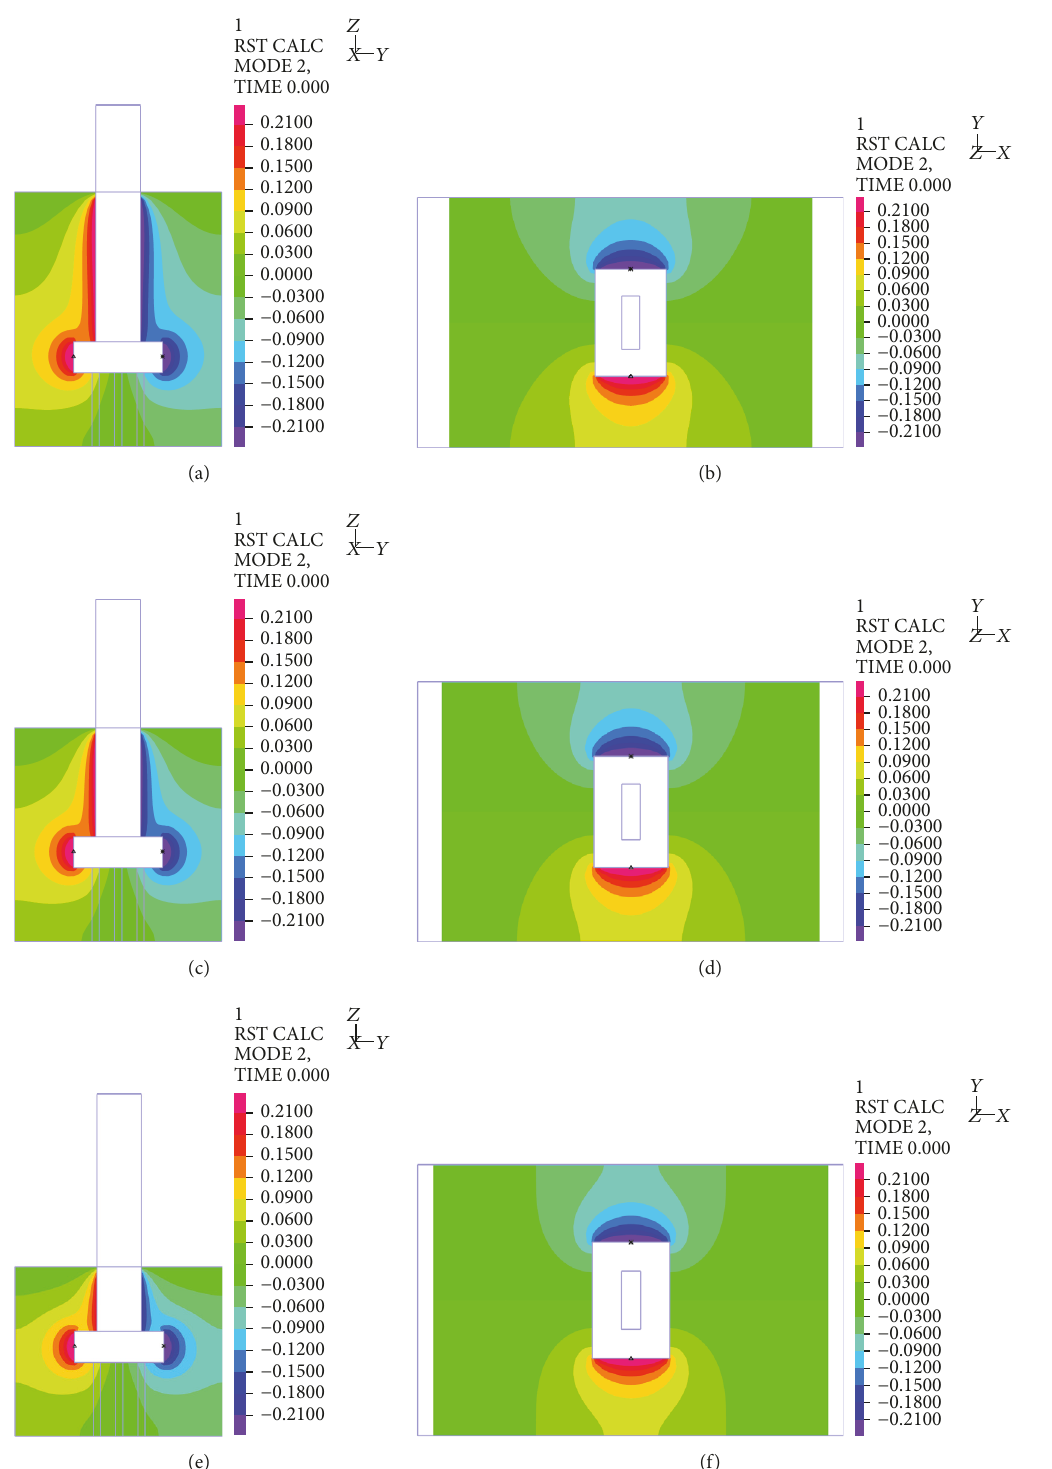
Figure 19: Nondimensional modal hydrodynamic pressures on the pier specimen without tip mass for the first mode along 𝑦 -axis; profiles for a water level, 𝐻 w , of 1.8m along cutting planes: (a) 𝑥 = 0 m and (b) 𝑧 = 0.65 m; profiles for a water level, 𝐻 w , of 1.5 m along cutting planes: (c) 𝑥 = 0 m and (d) 𝑧 = 0.65 m; profiles for a water level, 𝐻 w , of 1.2 m along cutting planes: (e) 𝑥 = 0 m and (f) 𝑧 = 0.65